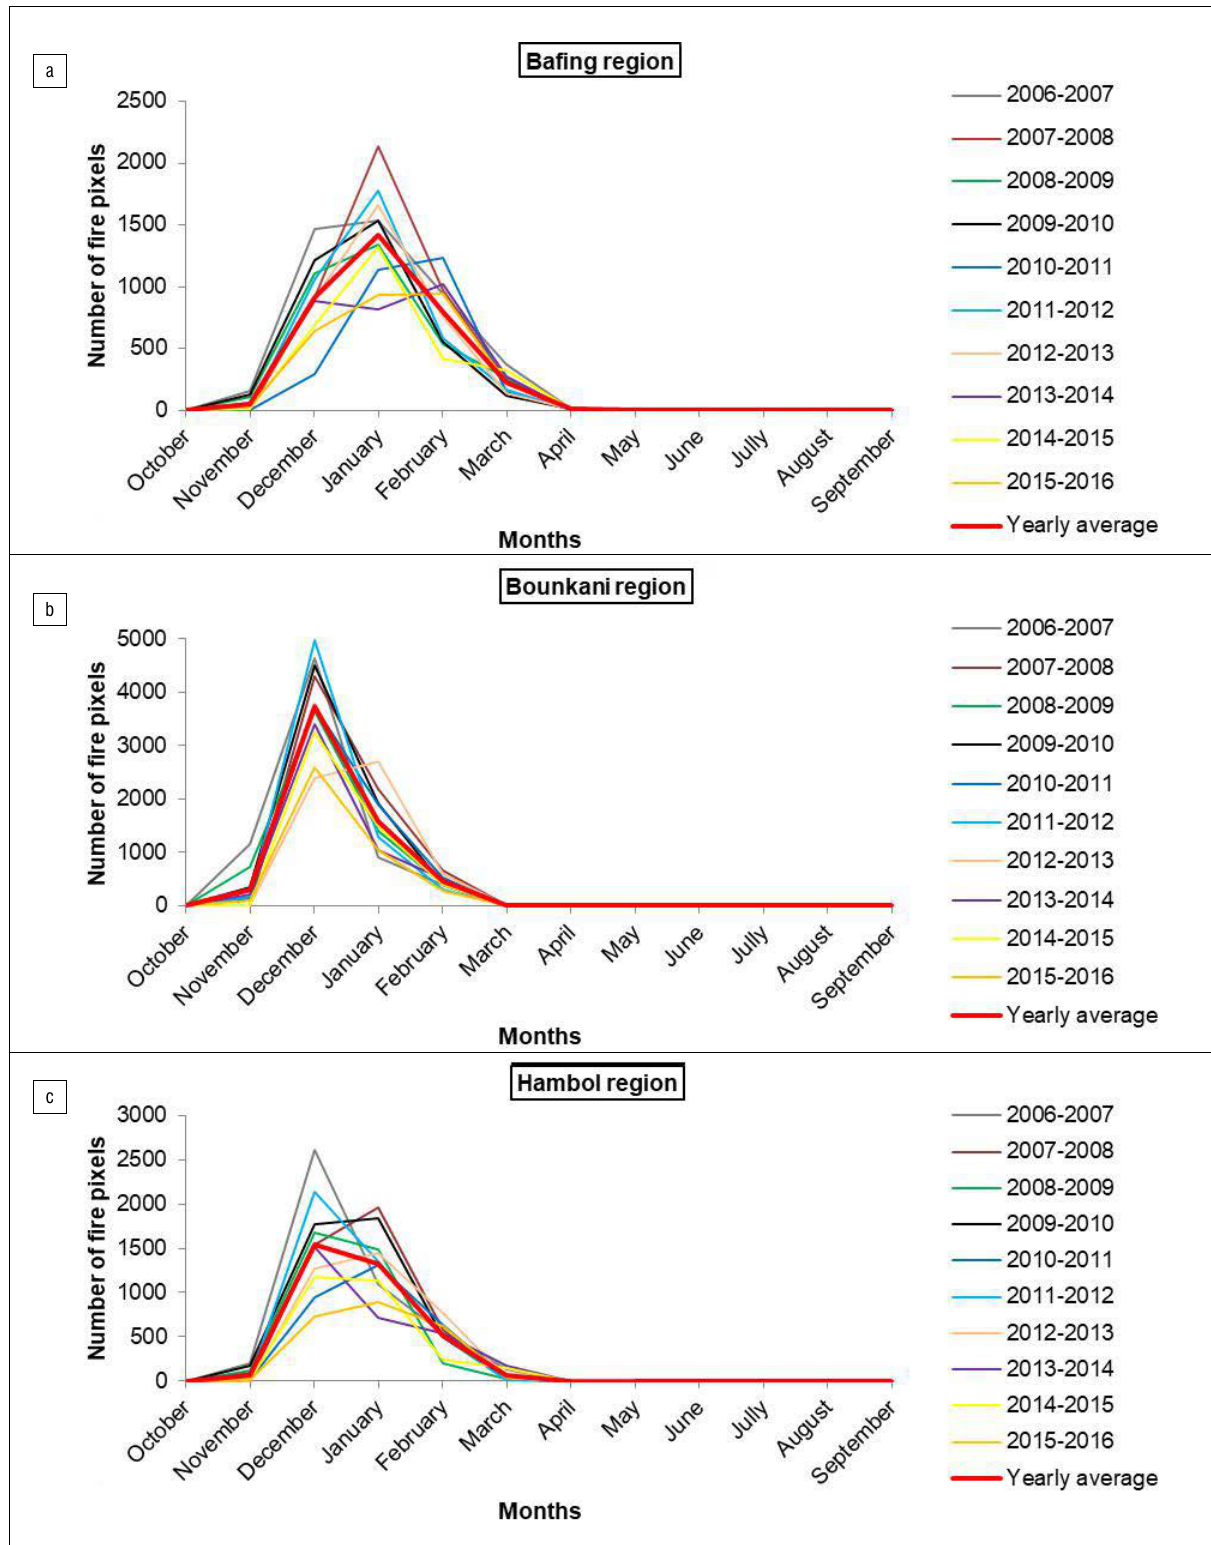
Figure 7: Temporal distribution of fire occurrence by month in the three main fire hotspots: (a) Bafing, main region of the North-Western hotspot; (b) Bounkani, main region of the North-Eastern hotspot; (c) Hambol, main region of the Central